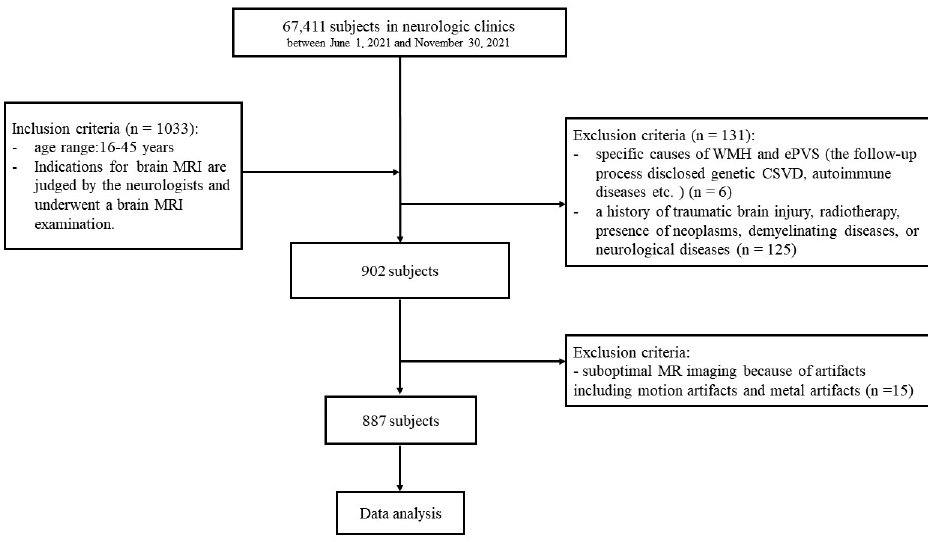
Figure 1. Subject screening work fl ow.